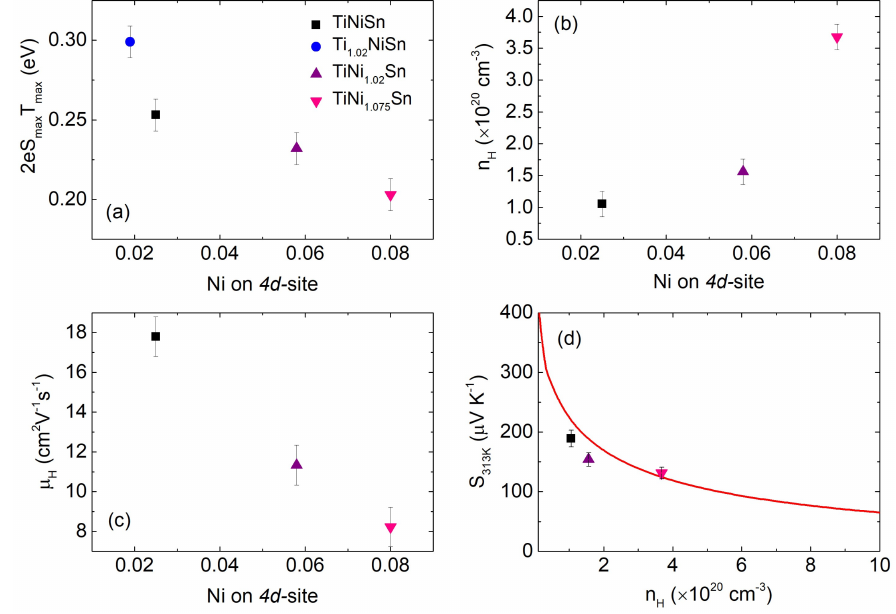
Figure 6. ( a ) Thermal band gap (E g ), ( b ) Hall carrier concentration (n H ), and ( c ) Hall mobility ( µ H ) versus Ni-4d site occupancy. ( d ) Pisarenko plot using a single Kane band with carrier effective mass m = 2.8 m e